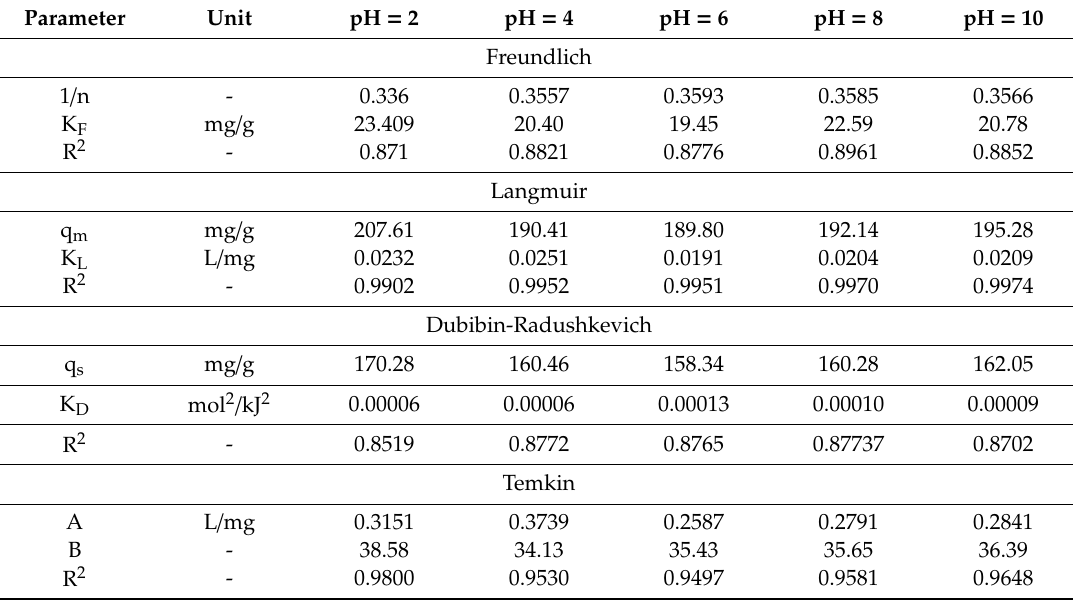
Table 7. Value of coe ffi cients of chloramphenicol adsorption isotherms depending on the pH of the solution (Freundlich, Langmuir (form I) and Temkin).